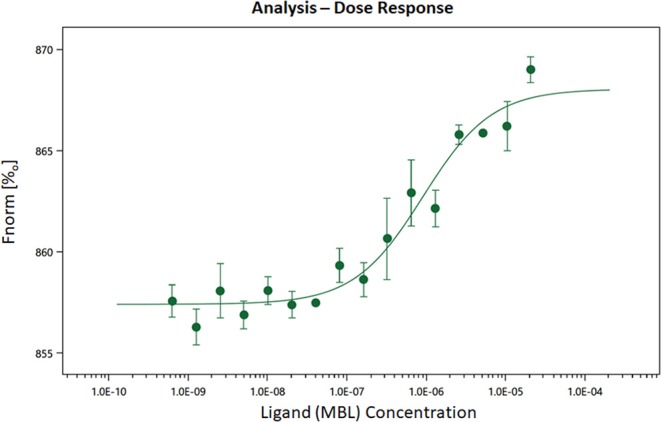
Microscale thermophoresis showing biophysical analysis of binding of human rMBL with human rTLR4/MD2. MST is based on the detection of a temperature-induced change in fluorescence of rTLR4/MD2 (target) as a function of the concentration of a non-fluorescent ligand (rMBL). By titrating MBL into the labeled TLR4 the Kd (dissociation constant) was 9.07 × E−07 indicating strong binding.